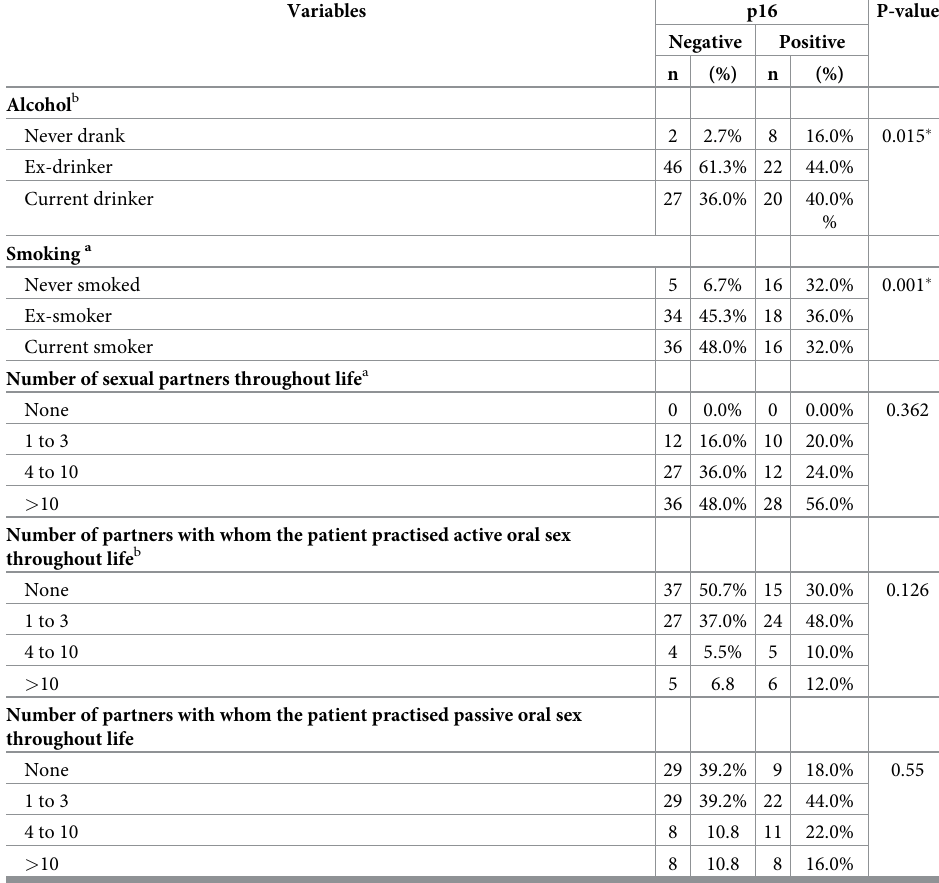
ª Analysis by the chi-squared test expressed as absolute (n) and relative (%) frequency b Analysis by Fisher’s exact test expressed as absolute (n) and relative (%) frequency